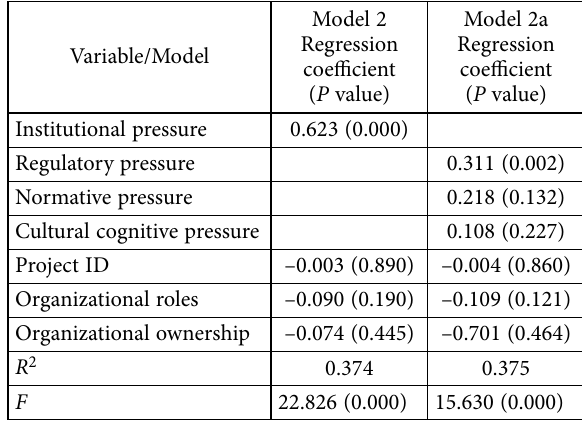
Table 6. Regression results for Model